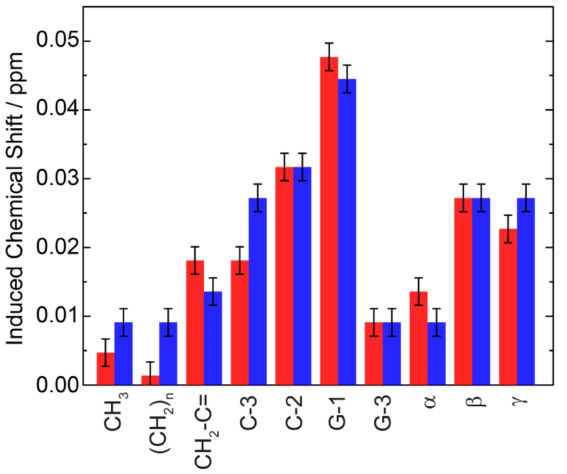
Figure 5. Induced chemical shifts for the 1 H signals of POPC due to ring current e ff ects in the presence of 10 mol% ibuprofen in a POPC (red) and in a POPC / cholesterol (80 / 20, mol / mol) membrane